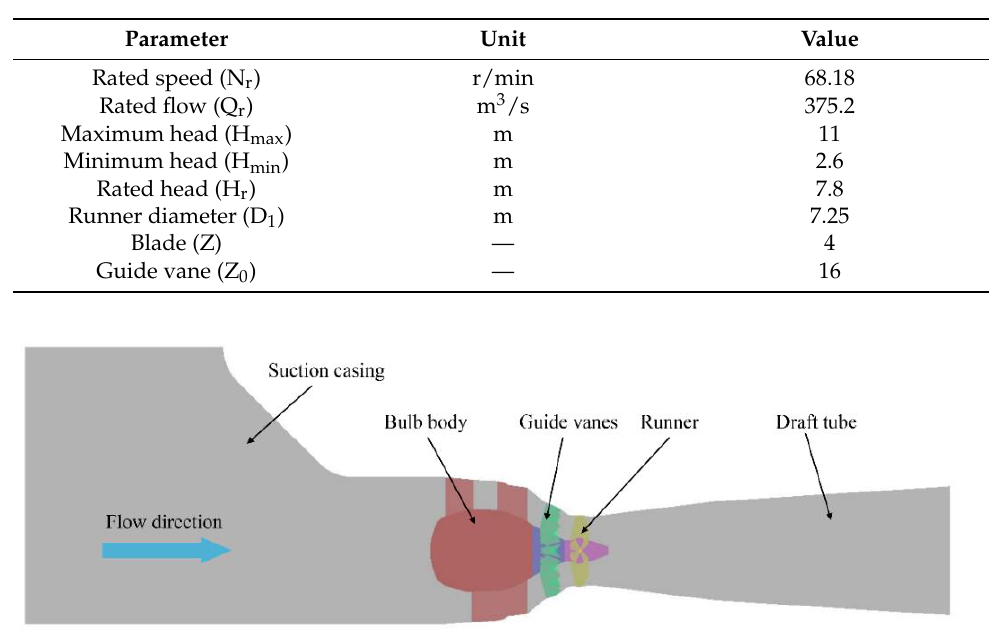
Table 1. Main design parameters of research objects.